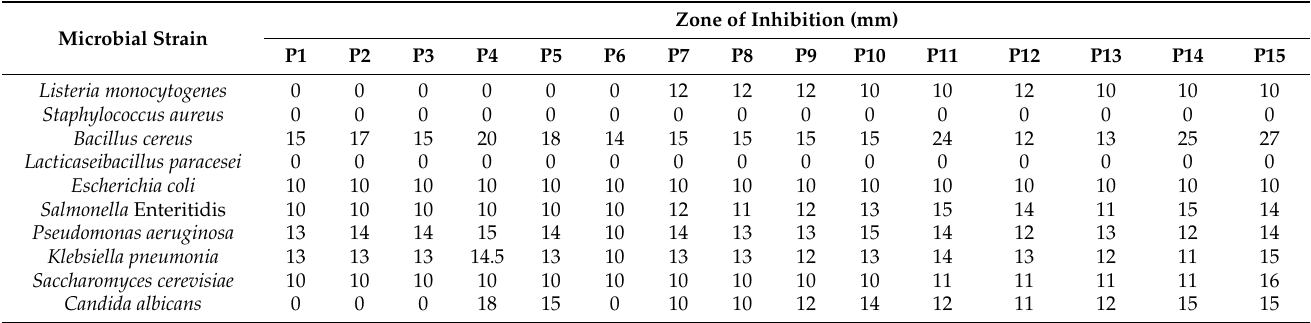
Table 2. The antimicrobial activity of propolis